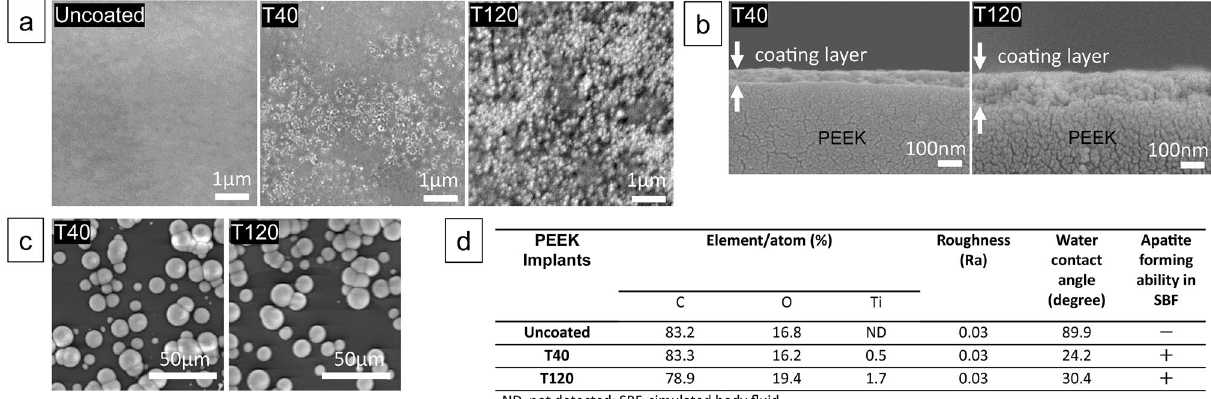
Figure 1. SEM images and surface characteristics of the PEEK implants: ( a ) uncoated implant shows a smooth surface, whereas the T40 and T120 implants show nano-scale precipitation on their surface; ( b ) cross-sectional SEM images of the T40 and T120 implants showing the uniformity of the sol–gel TiO 2 coating layers; ( c ) SEM images three days after soaking in a SBF demonstrating spherical apatite formation on the surface; ( d ) summary of the surface characteristics (Ti elements detection, uniform surface roughness, improved hydrophilicity) of the T40 and T120